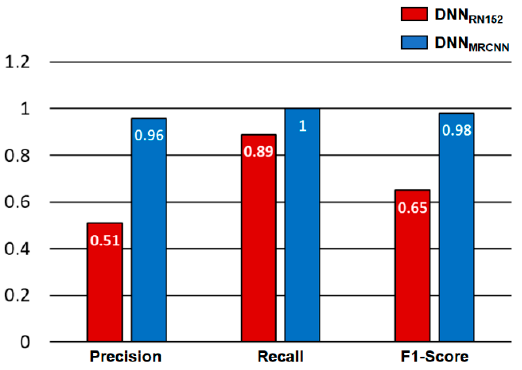
Figure 5. Comparison of performance evaluation results between two DNNs— DNN RN152 (red bar) and DNN MRCNN (blue bar).